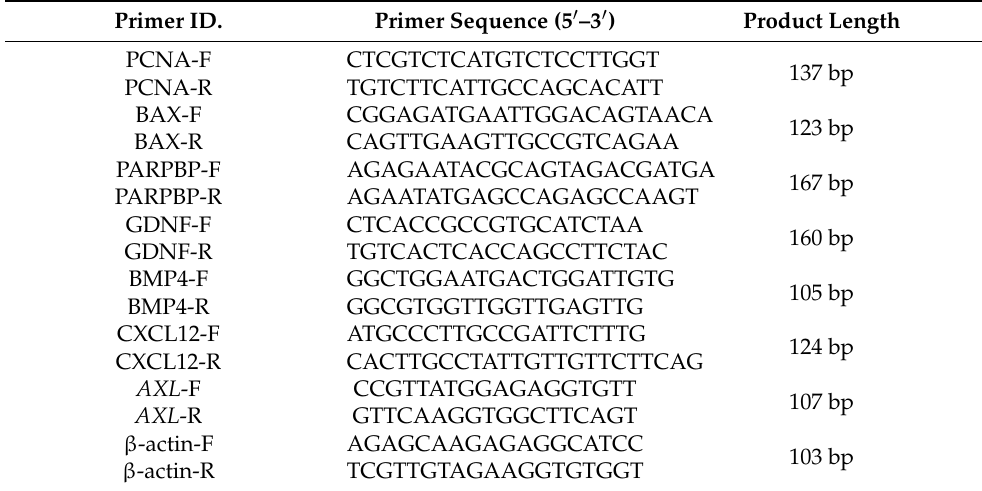
Table 2. Primers of qRT-PCR. Primer